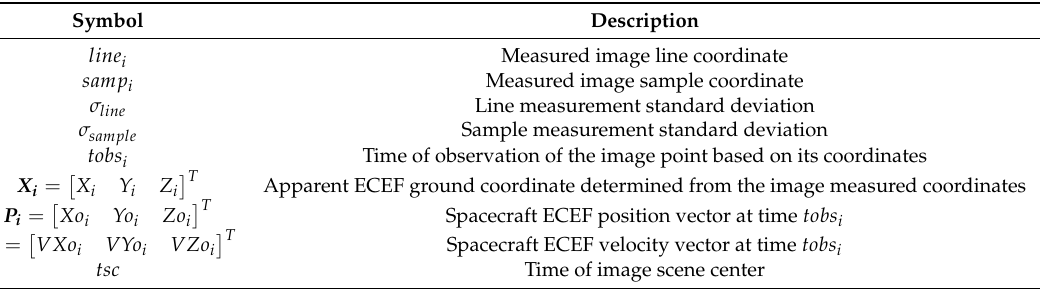
Table 1. Observation data collected for each observation point ( i